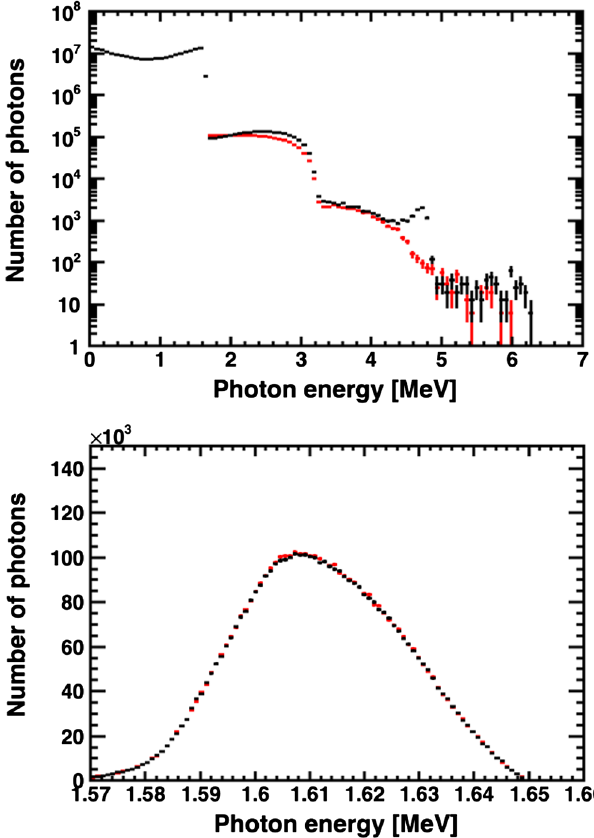
FIG. 3. Photon energy spectrum with all nonlinearities included for a circularly (linearly) polarized laser beam in red (black) in log-scale (top) and zoomed around the first order contribution within 200 μ rad aperture (bottom). On the latter the two distribution are hardly distinguishable by eye, as